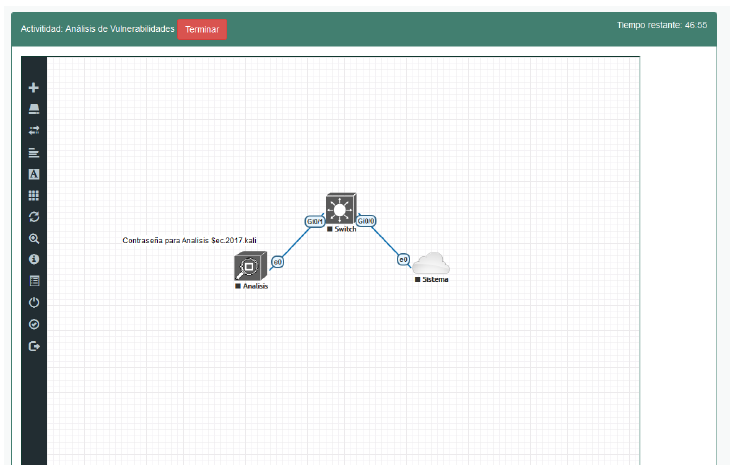
Figure 3. Network structure of the laboratory for the CIS